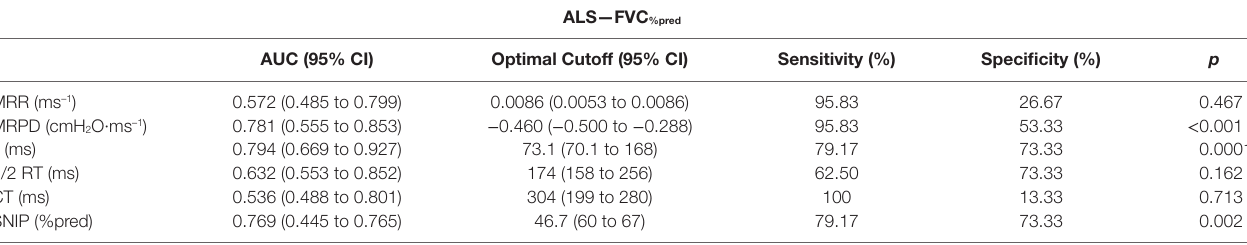
TaBle 6 | Receiver operating characteristic analysis between ALS subjects classified according to a decrease in FVC.